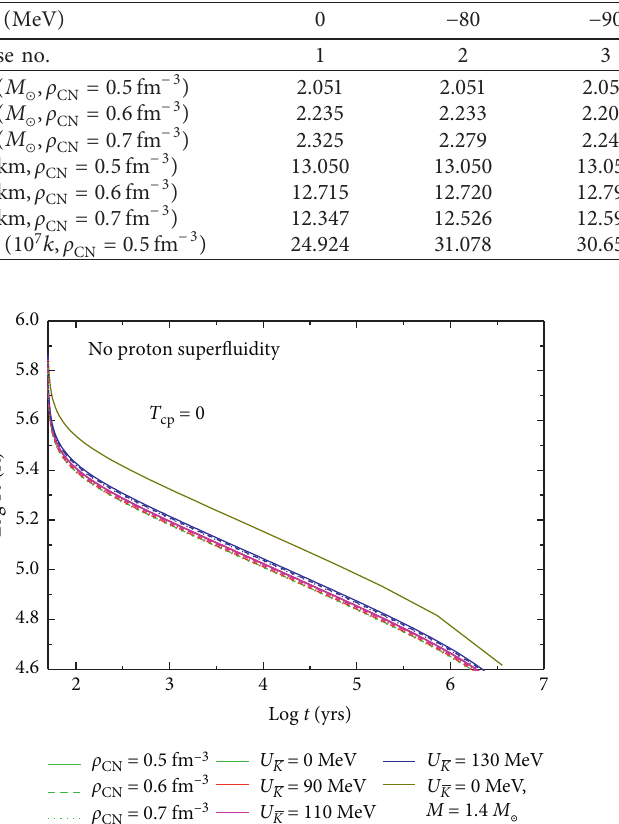
� 0 . 5 , 0 . 6 , 0 . 7fm − 3 and optical CN of the protonic 1 S superfluids is also cp 0